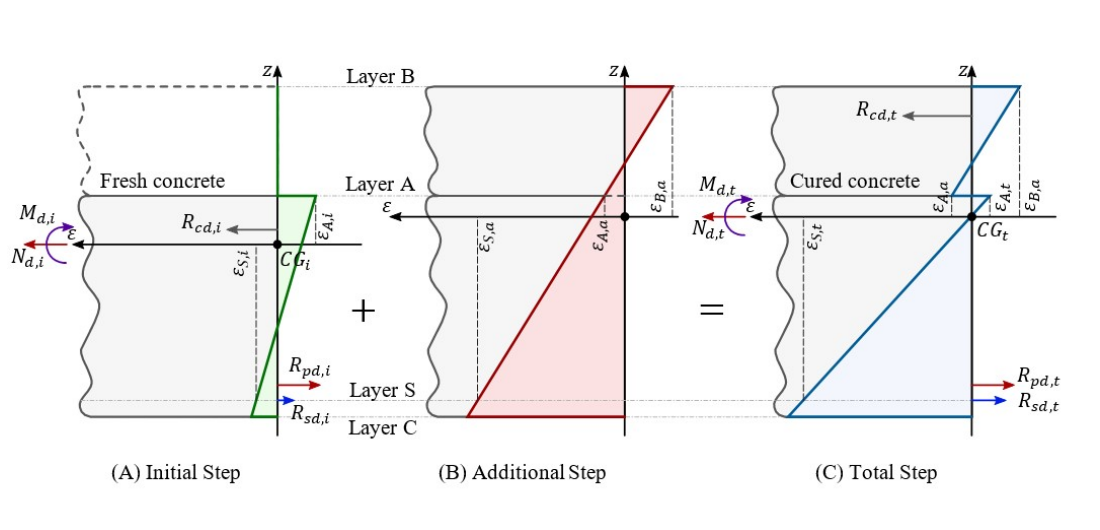
Figure 6. Evolution of strain in defined